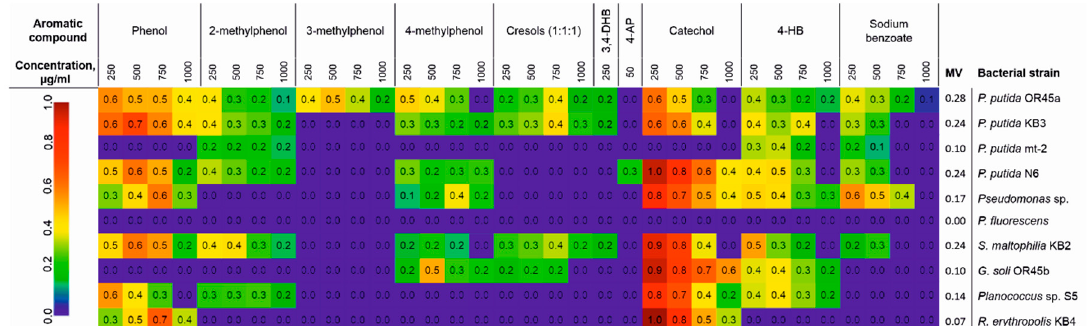
Figure 1. Analysis of the metabolic versatility (MV) of the candidates for bioaugmentation using Biolog ® MT plates. All of the data values were normalized and are presented as a color scale from navy blue (0) to red (1), which refer to inability and biodegradability of the tested aromatic compounds, respectively.